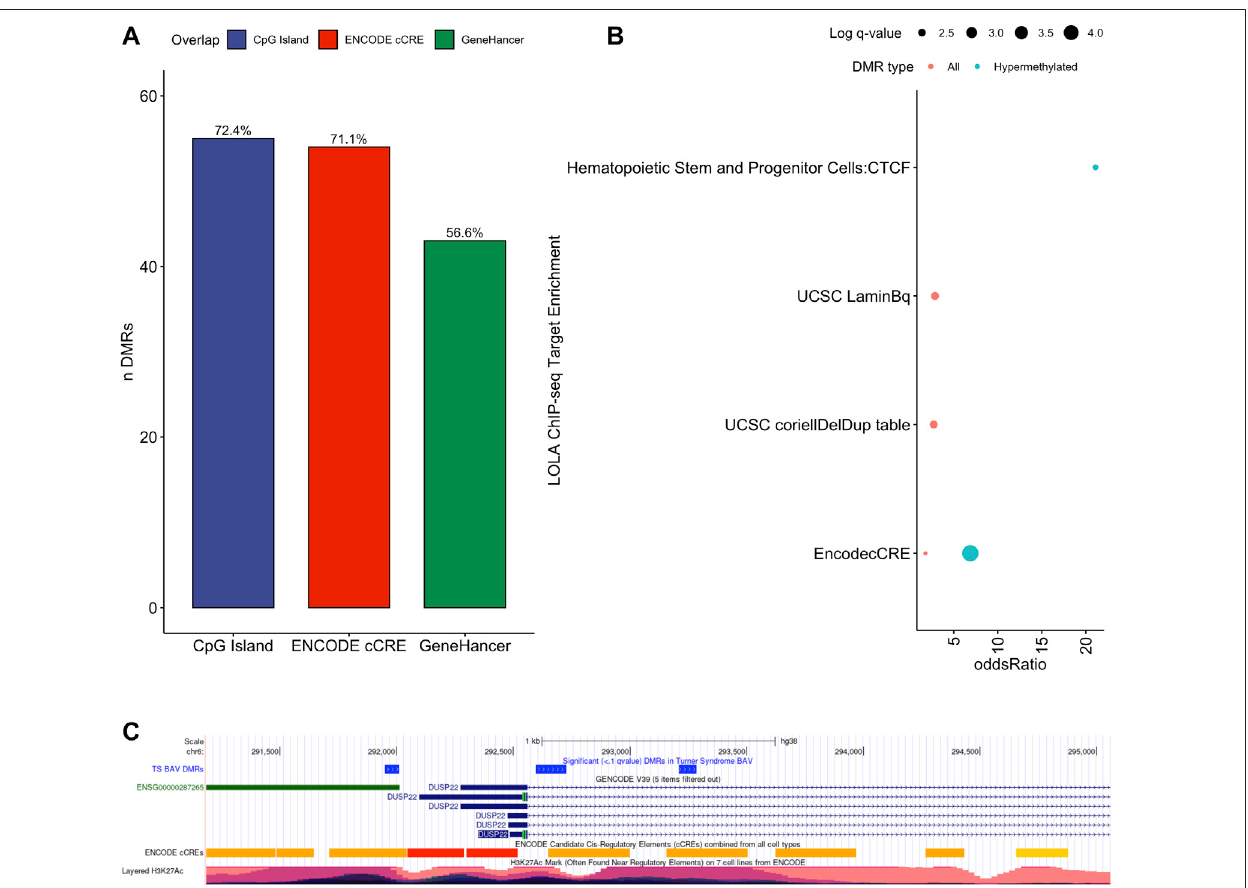
FIGURE 3 | Signi fi cant LOLA genome feature overlap enrichment for TS DMRs ( < 0.1 q value). (A) Dotplot of LOLA enrichment for UCSC features, Cistrome epigenomics database, Shef fi eld and Bock (2016) DNAse database, and Encode cCRE/GeneHancer overlap. (B) Dotplot of LOLA enrichment for CODEX database ChIP-seqpeak overlap forNOTCH1, MYH11, KDM4A,and HDAC2. (C) Three signi fi cantTSBAVDMRs displayed intheUCSCGenomeBrowser (http://genome.ucsc. edu) with ENCODE cCREs and H3K27ac tracks over the DUSP22 gene